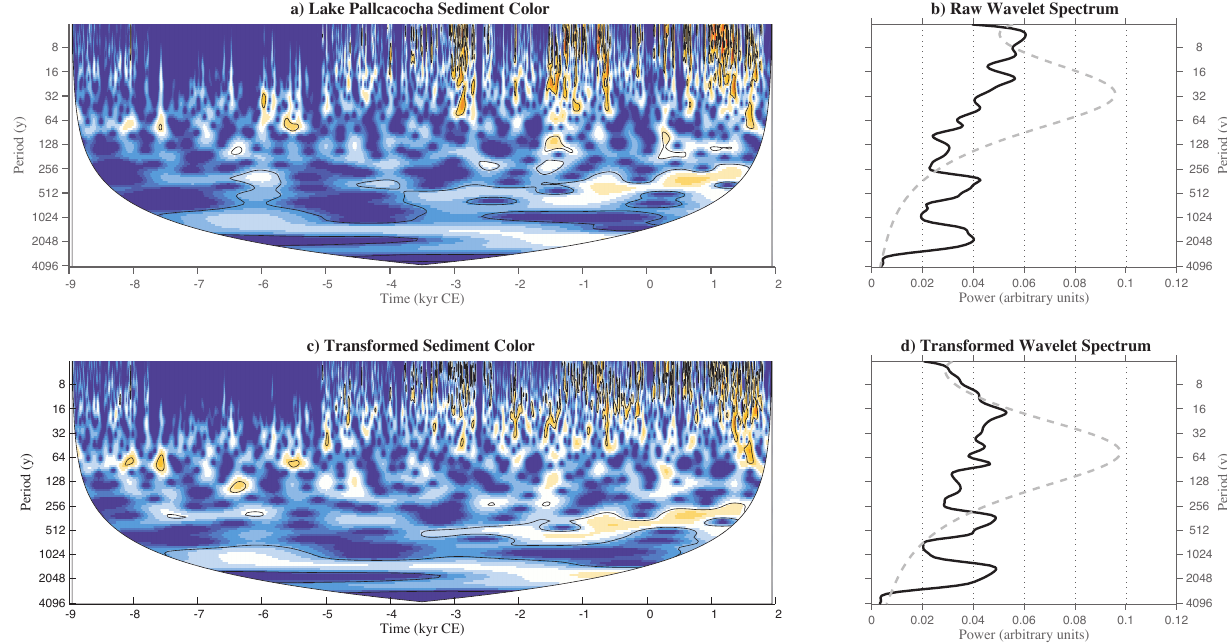
Figure 9. Wavelet analysis of the Laguna Pallcacocha record (Moy et al., 2002). (a) Morlet wavelet coefficients for raw values of the red colour intensity series, interpolated at 2-year intervals; (b) global wavelet spectrum (black), with the AR(1) benchmark plotted in grey. (c, d) As in (a, b) but for the transformed time series. Colour bars are omitted since units are